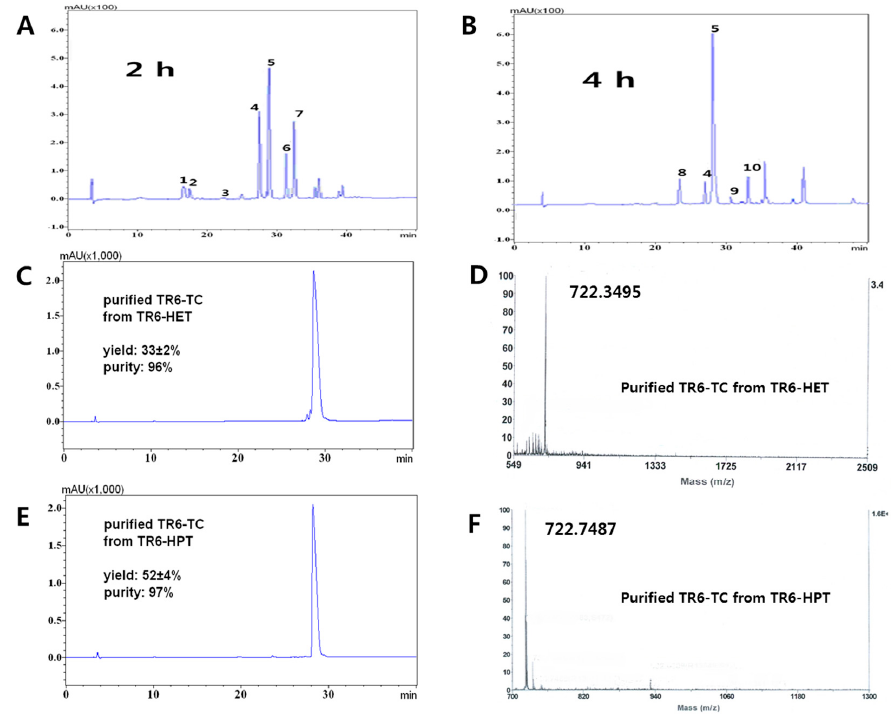
Figure 2. HPLC profiles of the main products between two different C-terminal handles, HET and HPT. Condition: 0.5% TfOH-5% TC-TFA (total volume; 1 mL): ( A ) TIGGIR-OEtSH